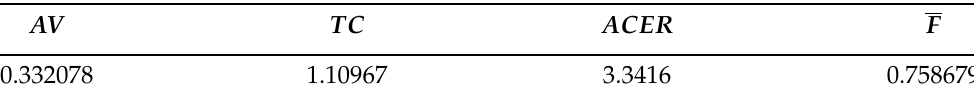
Table 7. Cost-effectiveness measures for the FractInt system. Parameters according to Tables 1 and 3 with C 1 = C 2 = 1.